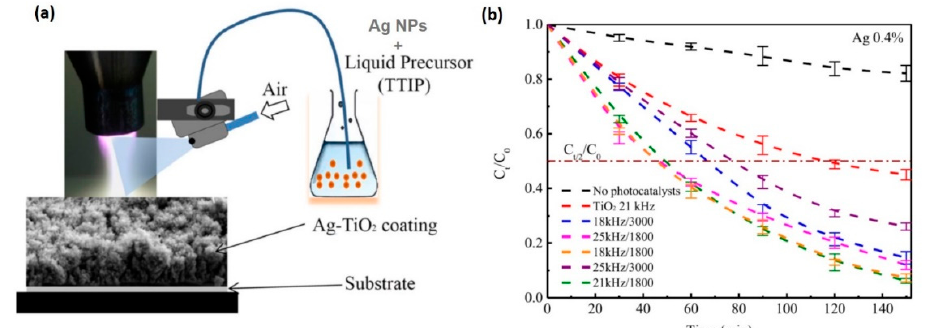
Figure 9. ( a ) Schematic of the APPJ system coupled with a homemade spraying system for one-step deposition of nano-Ag–TiO 2 coatings from the injection of Ag nanoparticles (NPs, with an average particle size of 100 nm) dispersed in TTIP liquid precursor on two di ff erent substrates, glass or Si(100), at 200 ◦ C. All the coatings were annealed in ambient air for 1 hr at 450 ◦ C. ( b ) Photocatalytic degradation kinetics for rhodamine B over 2.5 h on glass coated with the Ag–TiO 2 catalyst under a 125-W Philips white light source at a fixed concentration of Ag NPs (0.4%) and under di ff erent pulse frequencies (kHz) and air flow rates (L / h), compared with the substrate without any photocatalyst, and for the TiO 2 coating. In particular, the samples prepared with a pulse frequency of 18 or 21 kHz and an air flow rate of 1800 L / h showed the best photocatalytic activities, with a half-life of ~50 min, by which time the number of Rh.Bs decreased by half compared (C t / 2 ) to the initial concentration (C 0 = 5 mg / L). Copyright 2019 Wiley. Used with permission from [112].